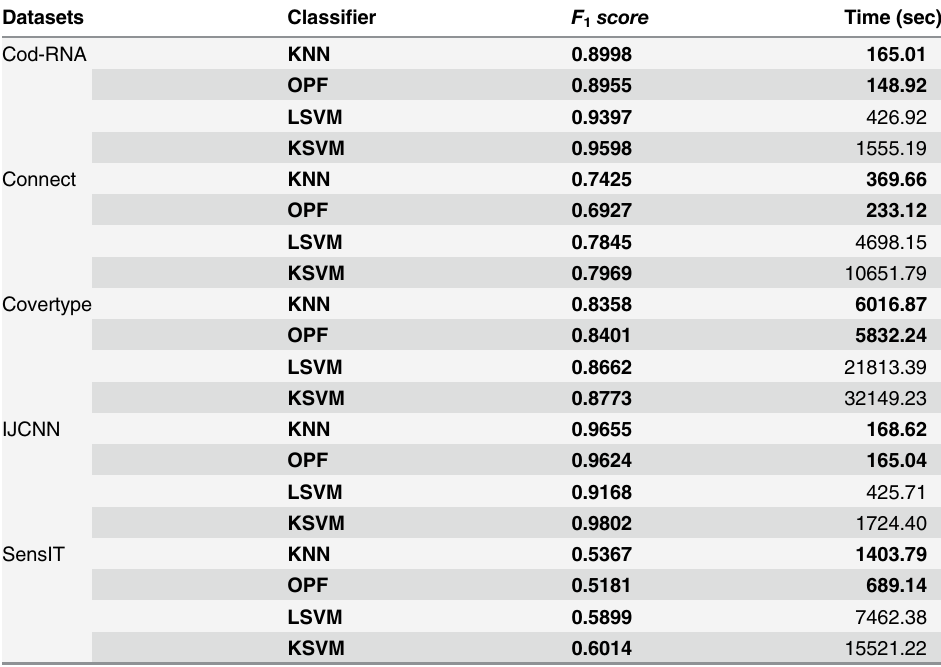
Table 13. Predictivity performance over Z 3 and required time for each classification model and data- set using all learning samples, j Z 2 j .